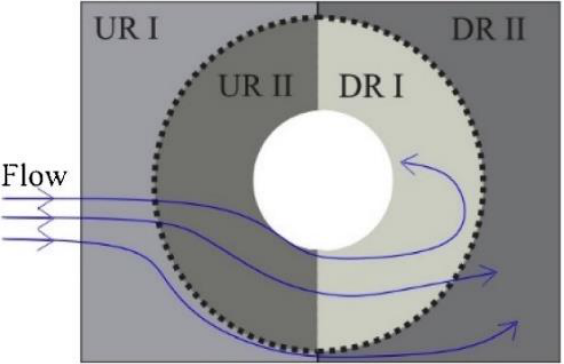
Figure 2. Schematic representation of flow regions; figure reprinted from Durhasan and Pinar [29] Copyright (2019), with permission from Elsevier.